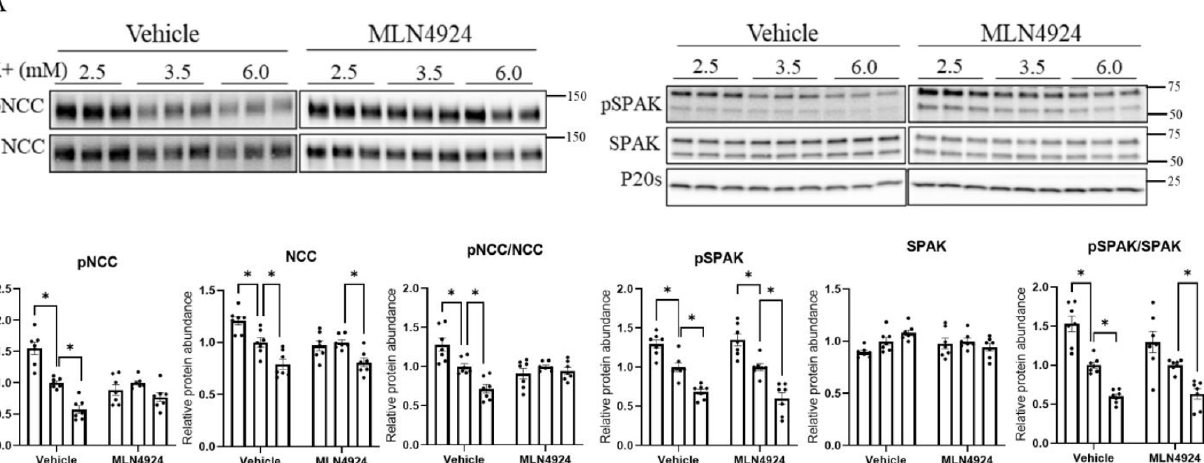
Figure 8. Long-term lower extracellular K + fails to induce NCC phosphorylation and abundance in the presence of MLN4924 in isolated renal tubules ex vivo. ( A ) Representative immunoblots of pNCC, NCC, pSPAK, SPAK, and P20s in isolated renal tubules that were incubated in the media containing different K + concentrations (2.5, 3.5, or 6 mM K + ) in the presence of either the vehicle or cullin inhibitor (MLN4924; 0.5 uM) for 24 h ex vivo. Molecular weight markers (kDa) are shown on the right. ( B ) Summarized relative protein abundance data. Each dot represents value from an individual well of independent tubules and each bar represents mean ± SEM obtained from two independent experiments ( n = 6). * indicates p < 0.05 relative to 3.5 mM K + in their respective